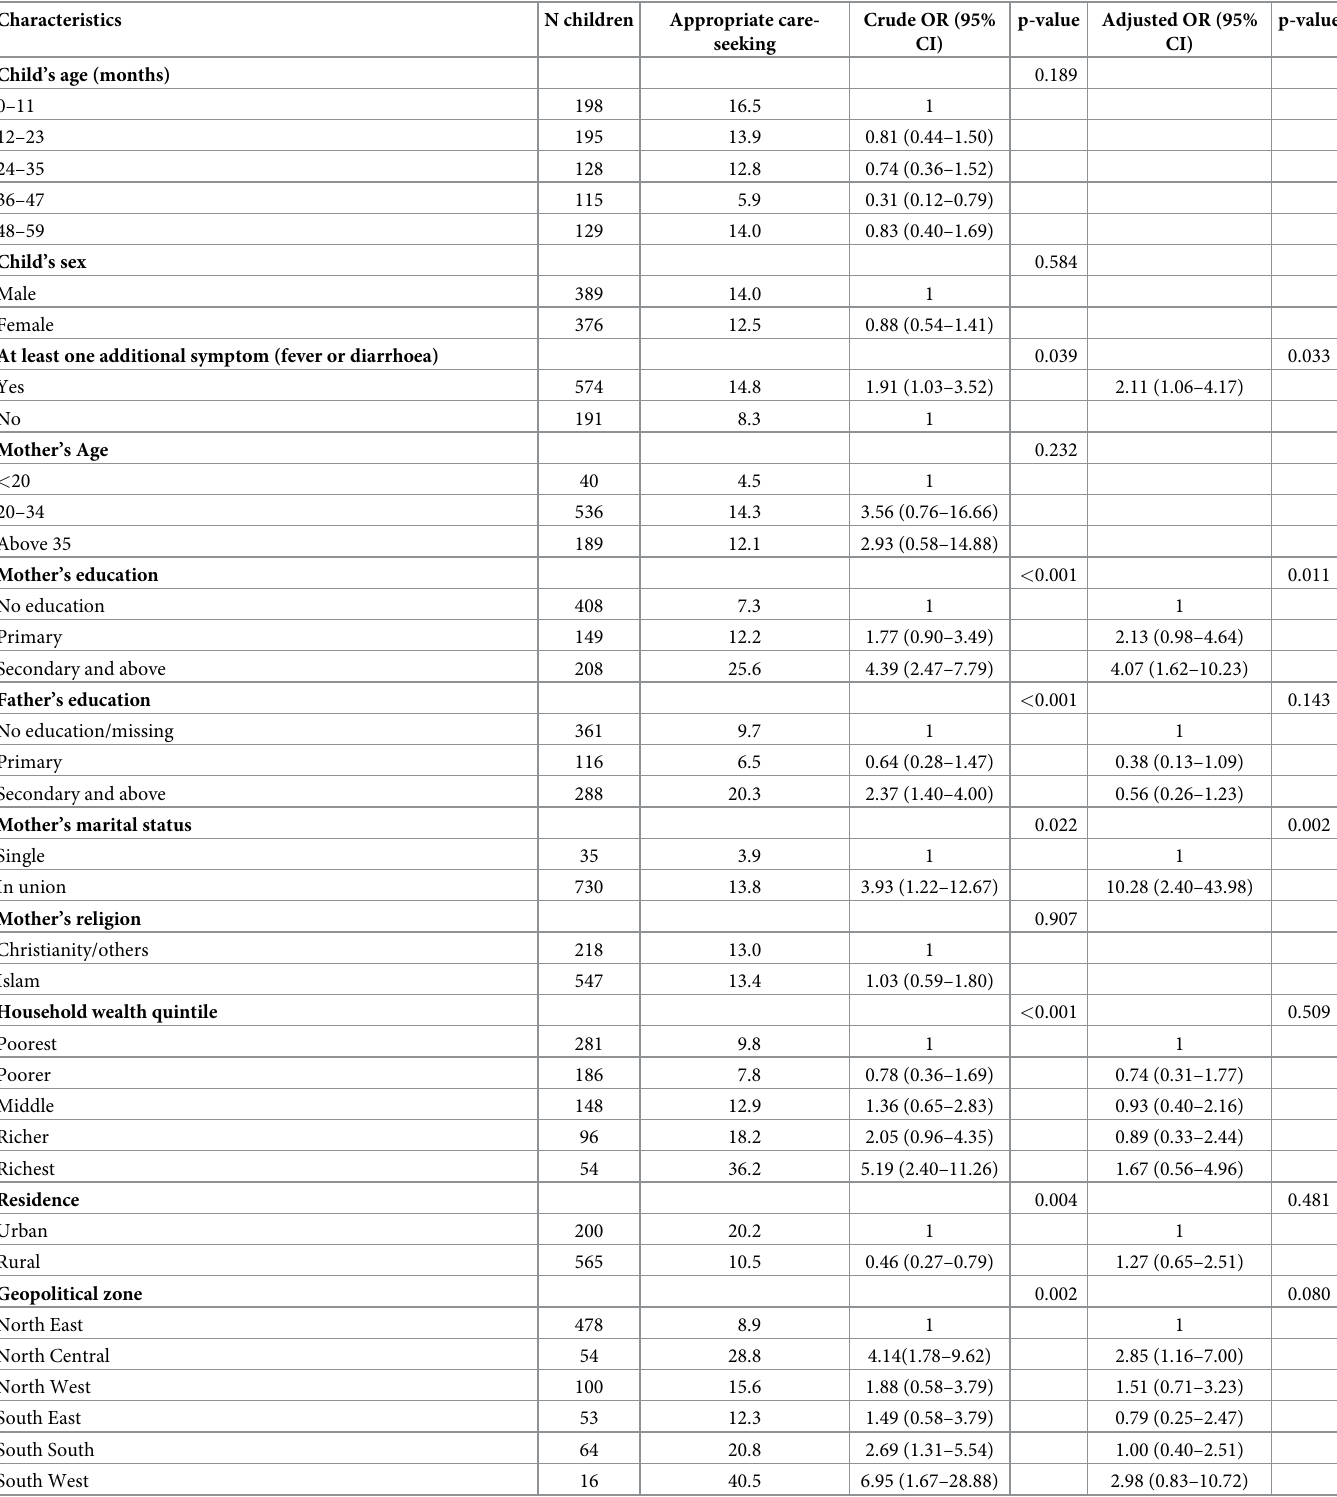
Table 4. Logistic regression analysis of factors associated with appropriate care-seeking behaviour for children under five with ARI symptoms (N = 765).